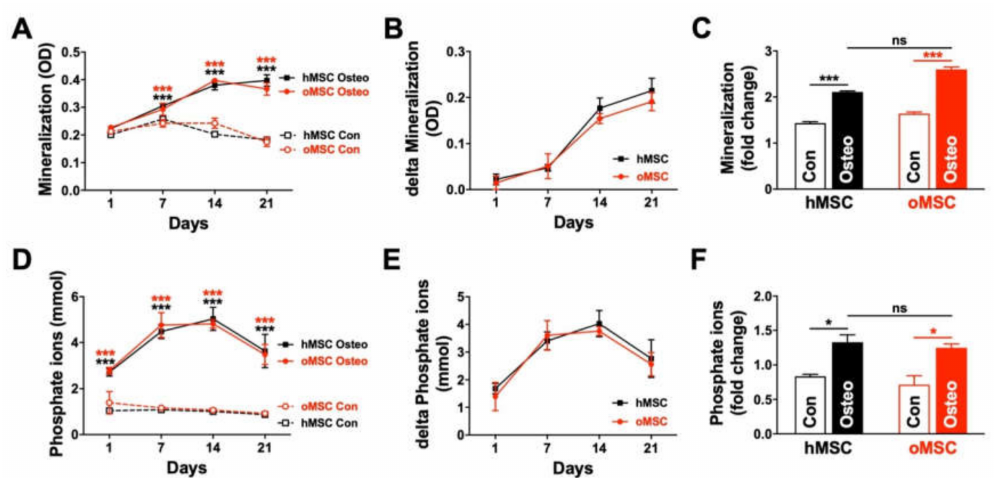
Figure 5. Comparable mineralization and phosphate ion release during the osteogenic di ff erentiation process. Mesenchymal stromal cells (MSC) from osteoporotic (oMSC) and healthy